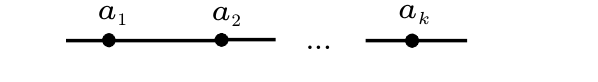
The plumbing graph realizing T 2 mapping cylinder associated to the